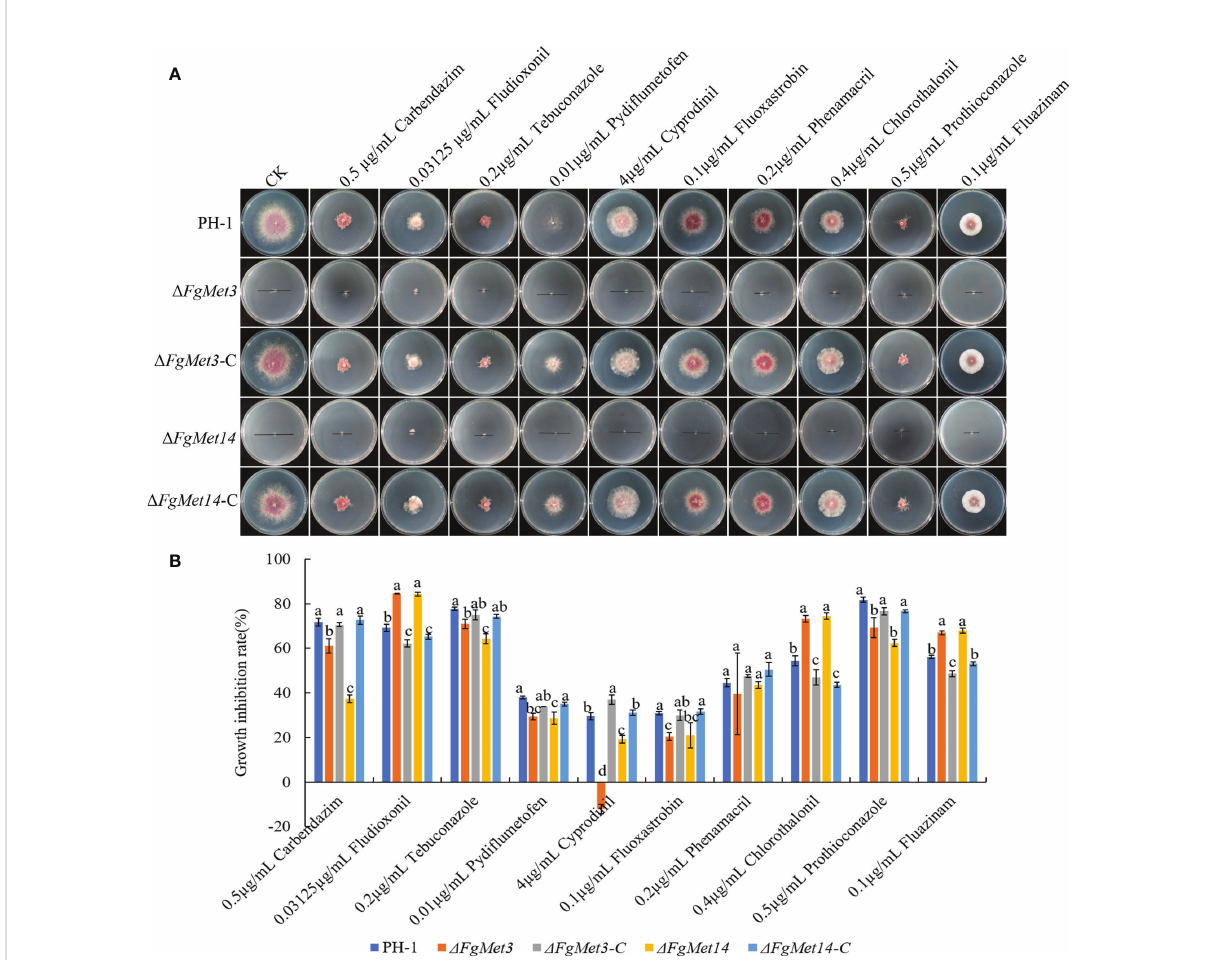
FIGURE 4 The sensitivity of D FgMet3 and D FgMet14 to different fungicides compared with PH-1 and complements. (A) Effects of 0.5 m g/mL carbendazim, 0.03125 m g/mL fl udioxonil, 0.2 m g/mL tebuconazole, 0.01 m g/mL pydi fl umetofen, 4 m g/mL cyprodinil, 0.1 m g/mL fl uoxastrobin, 0.2 m g/mL phenamacril, 0.4 m g/mL chlorothalonil, 0.5 m g/mL prothioconazole and 0.1 m g/mL fl uazinam on mycelial linear growth of D FgMet3 and D FgMet14 mutants. (B) The inhibition of the mycelial growth rate was examined after each strain was incubated for 3 days on